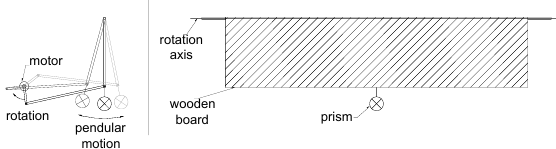
Figure 1: Side view (left part) and front view (right) of the apparatus